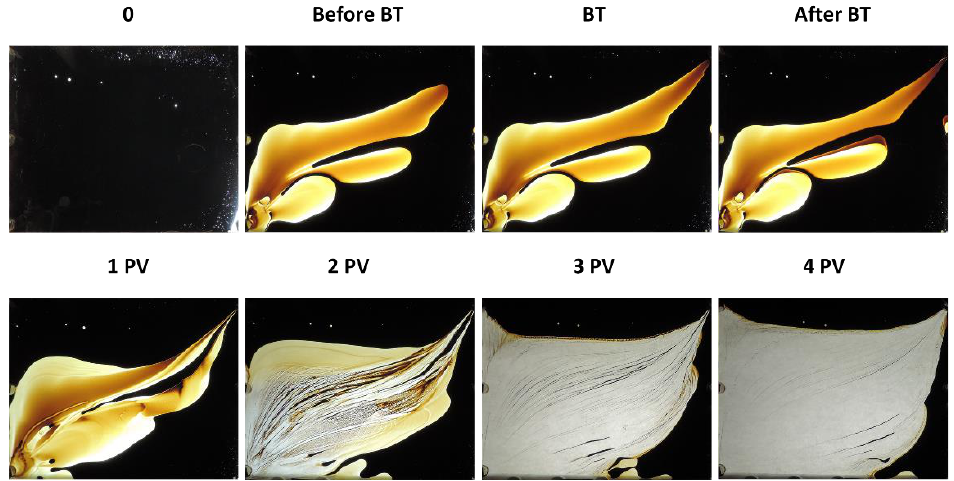
Figure 15. Crude oil displacements by 1.5 PV of polymer injected, followed by 2.5 PV of SP injected at 0.3 mL/min.